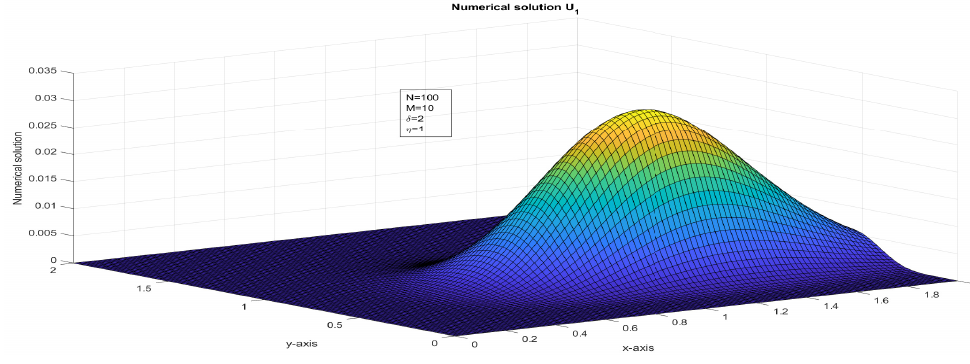
Figure 2. The surface plot illustrates the numerical solution, U 2 , for Case 1 in Example 1.